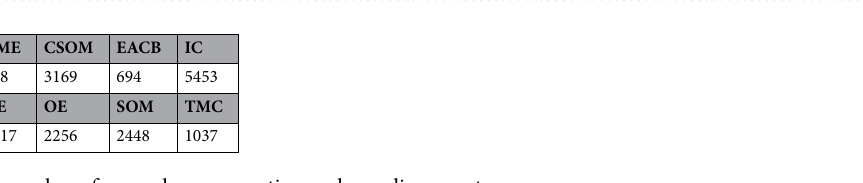
Table 2. The number of examples representing each ear disease category.